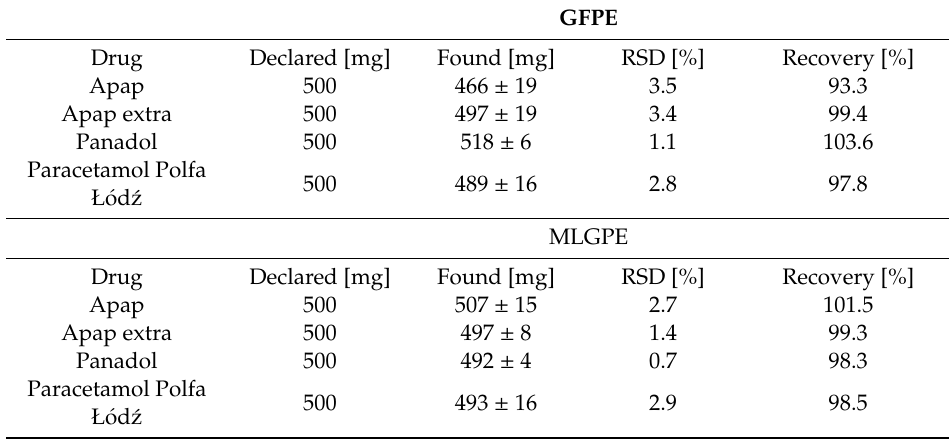
Table 3. The results of AC determination in pharmaceutical formulations by using the standard addition method on GFPE and MLGPE (n =